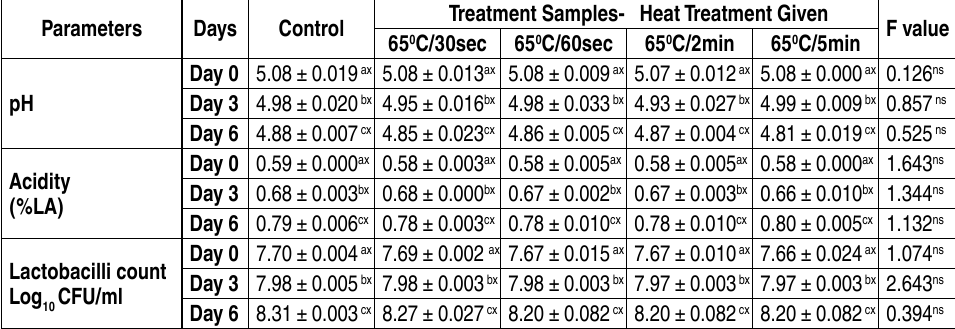
Table 3. pH, titratable acidity and count of Lacticaseibacillus casei 01 dahi samples subjected to thermization